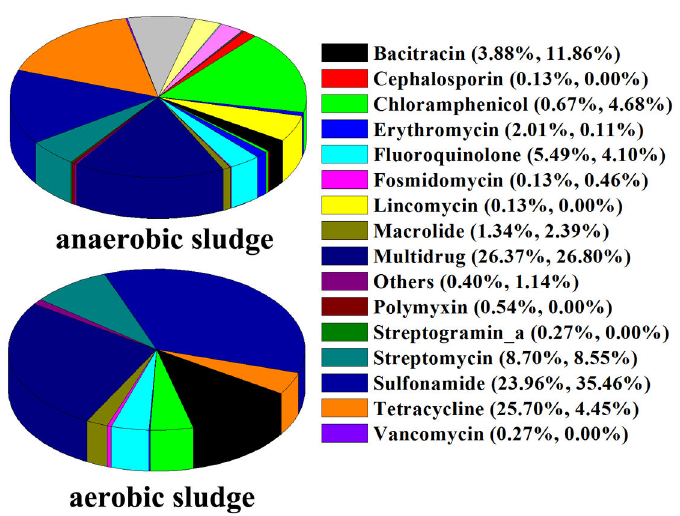
Figure 4. Antibiotic resistance gene patterns in anaerobic and aerobic sludge. The resistance genes were grouped after alignment of the high-throughput sequencing reads against ARDB database. The two percentages shown in the brackets represents the proportions of the reads of each antibiotic resistance gene (ARG) in the total reads of all the identified ARGs in anaerobic (first number) or aerobic (last number)